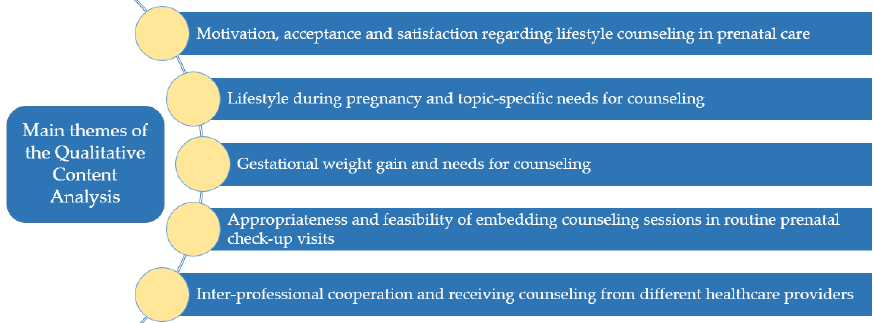
Figure 1. Main themes of the Qualitative Content Analysis.